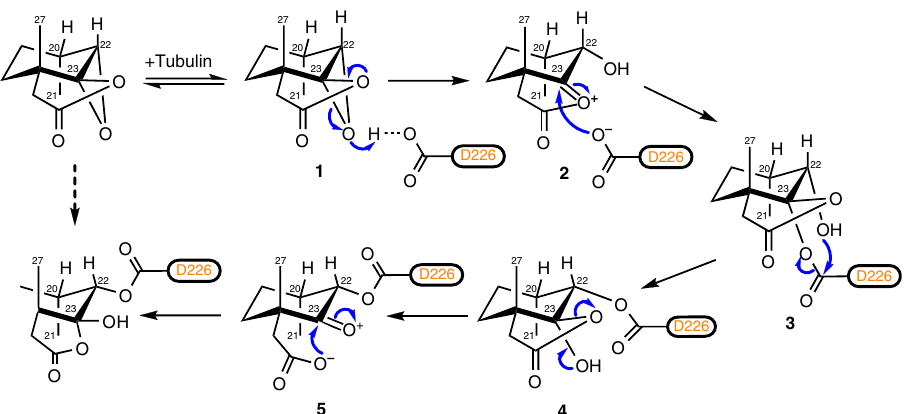
Figure 3 | Possible reaction mechanisms of the ester bond between taccalonolide AJ and b -tubulin D226. When AJ binds to the taxane site, the epoxy ring between C22 and C23 approximates the carboxyl group of b D226 and is activated by protonation; then, C23 is attacked by the carboxylate of D226 resulting in the formation of the oxirane ring-opening hydroxyl intermediate 3 , followed by an interesterification to form intermediate 4 . The five-membered ring of intermediate 4 has two adjacent carbons on the six-membered ring in trans position, in which the ring strain is relatively large, thus driving to proceed another interesterification to form the complex 5 , as observed in the crystal